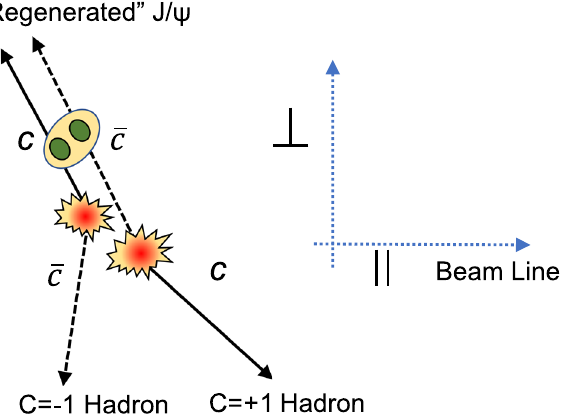
Fig. 4 Illustration of the J /ψ “regeneration” and how it leads to cor- relations between the J /ψ and the “associated” charm hadrons